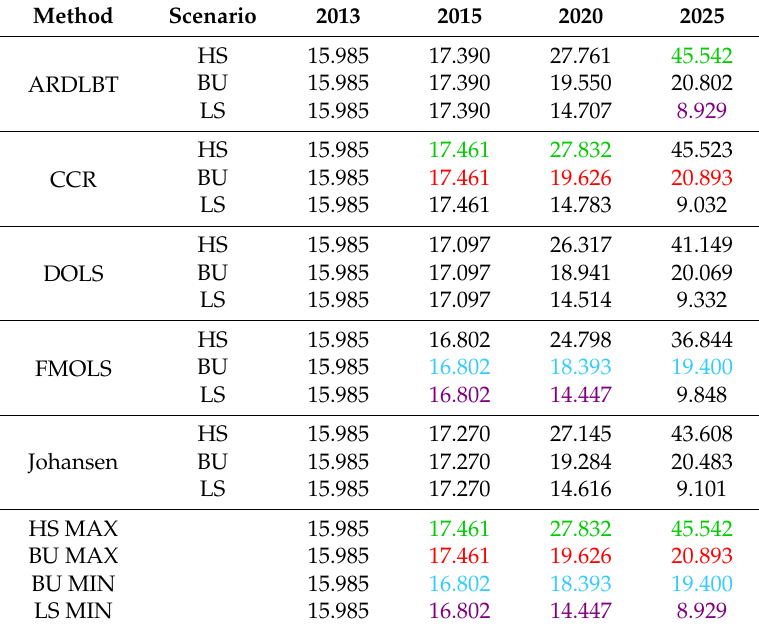
Table 11. Projected electricity consumption,